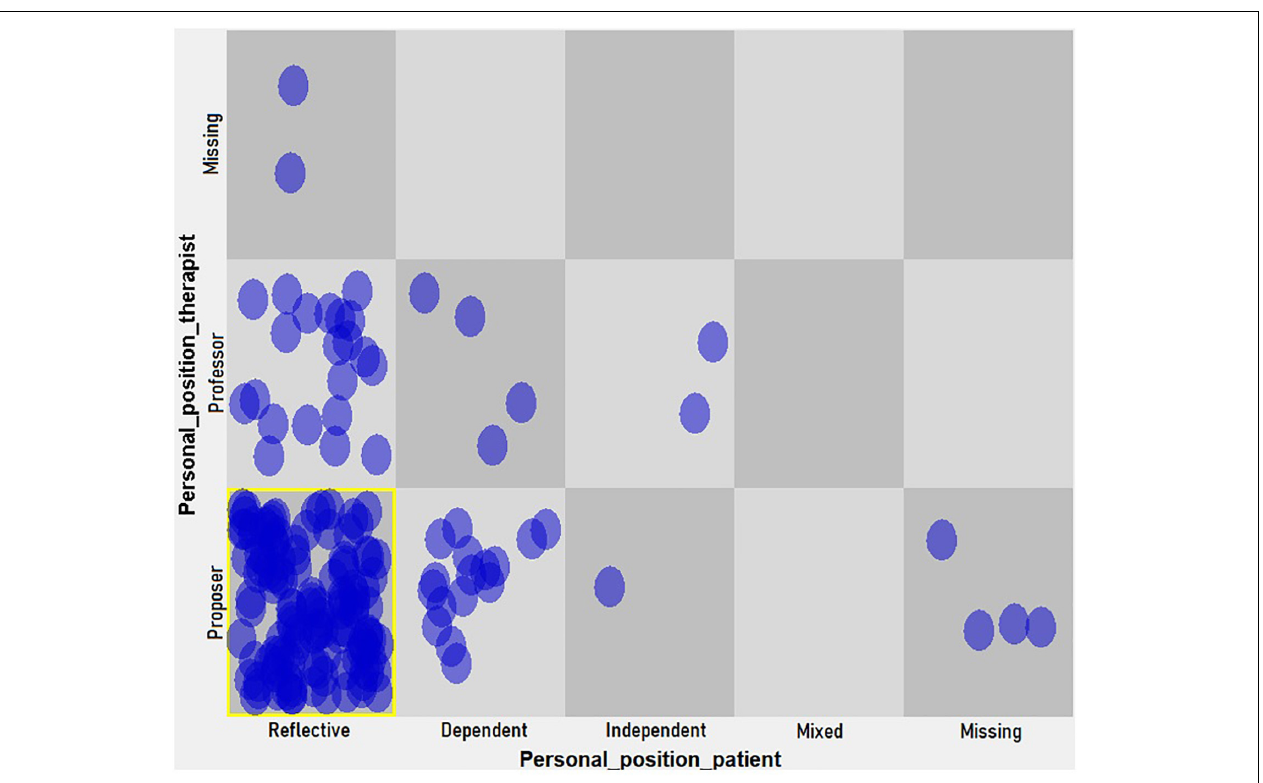
FIGURE 4 | Dynamic pattern in personal positions of the patient and her therapist (level 3, change